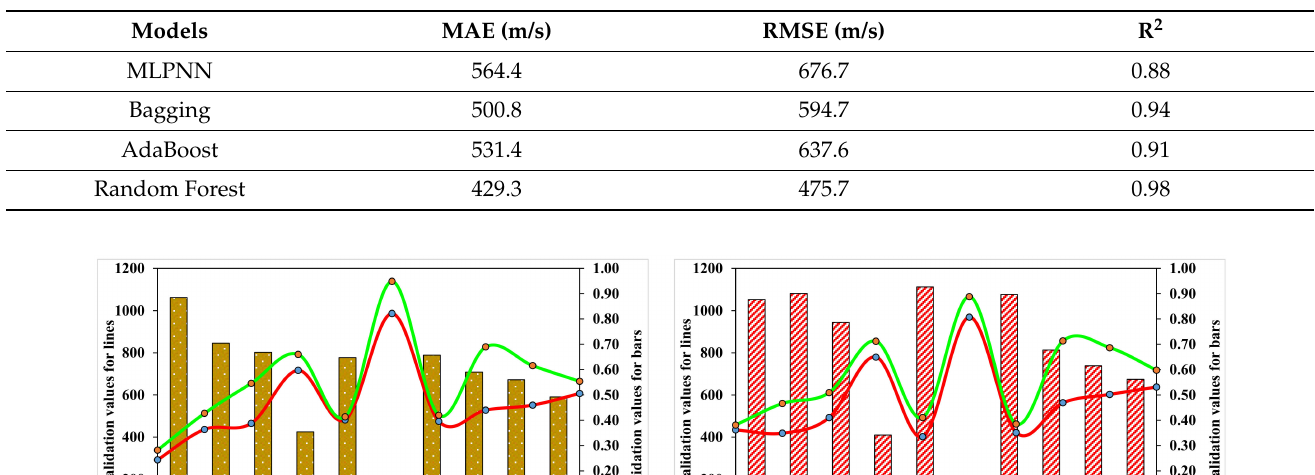
Table 4. Statistical descriptions of MLPNN, Bagging, AdaBoost, and Random Forest models.